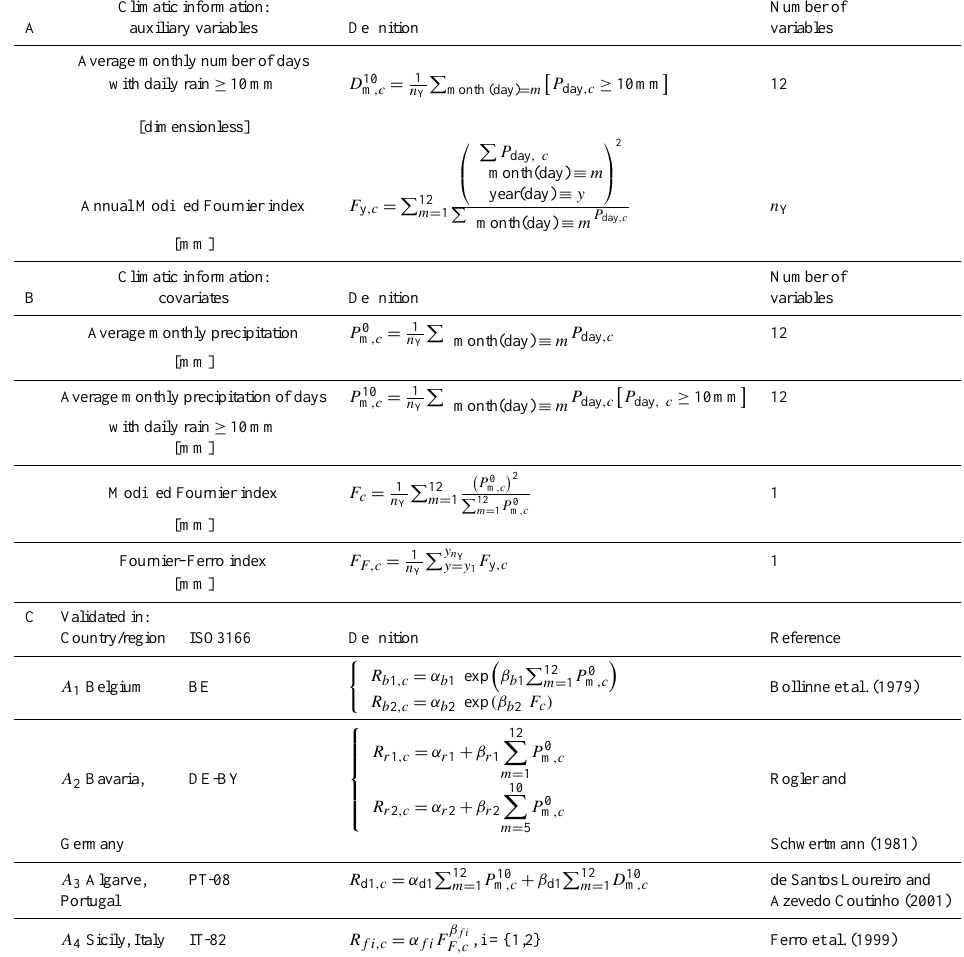
Table 1. Climatic information: auxiliary variables (A) and covariates (B) based on precipitation patterns in a given spatial grid cell c ; P day ,c and P m ,c respectively refer to the precipitation in c for the day [day] and the month [ m ]. The values are computed considering years y in a set of n Y years. In C, a list of empirical equations is provided for estimating the rainfall erosivity (EI 30 ). Climatic